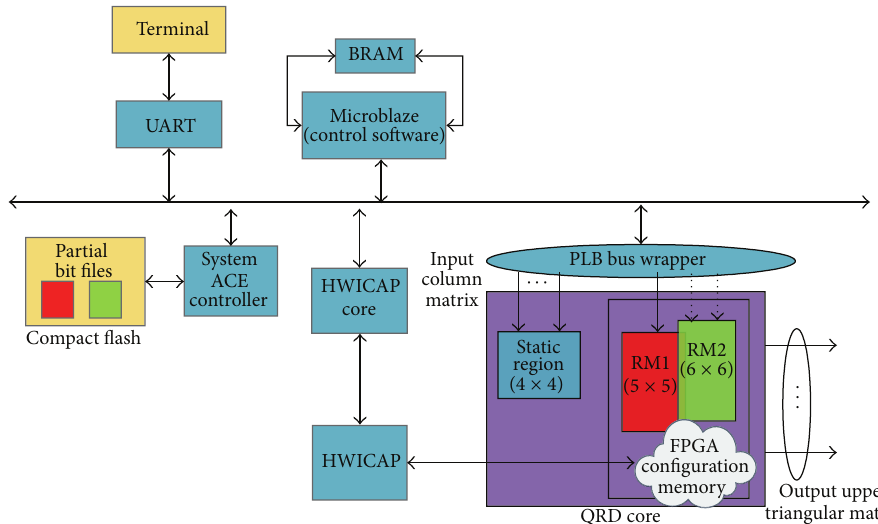
Figure 7: Block diagram representation of control logic for implementing DPR for scalable QRD core.